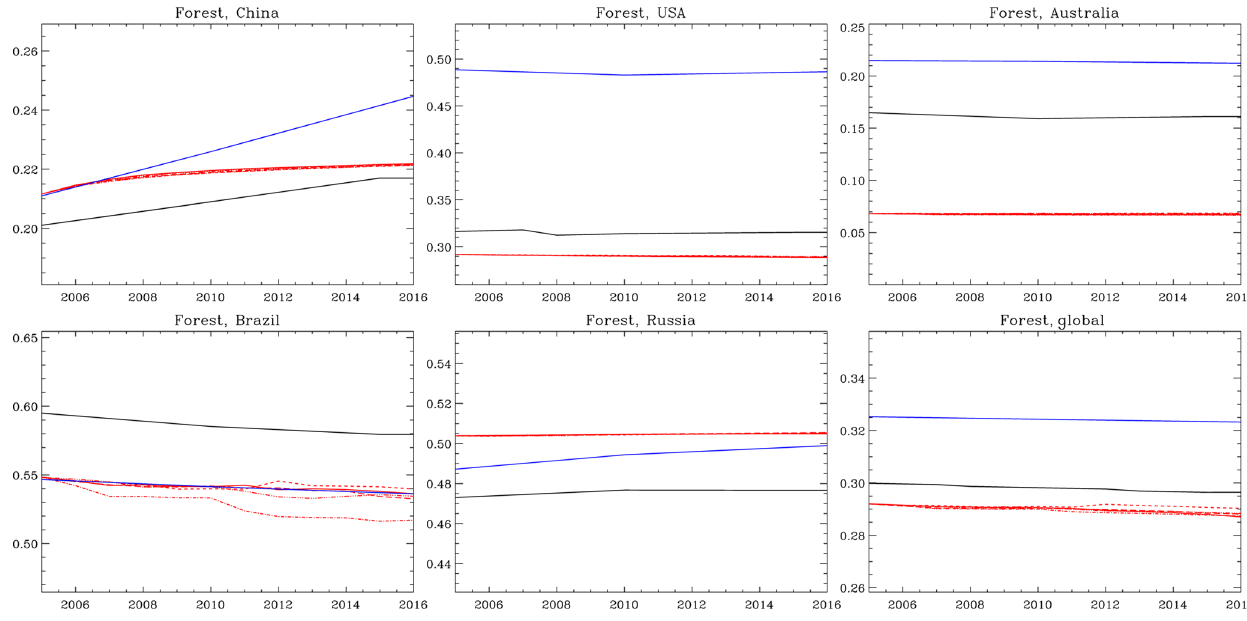
Figure 9. Same as Fig. 7 but for the historical forest area simulated by MIROC-INTEG-LAND (red), AIM/CGE (blue), and FAO (black), using the ratio of forest area to total area.